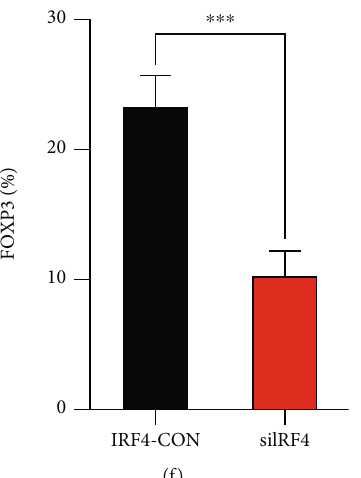
Figure 6: (a and b) PD-L1 ’ s fl ow cytometry analysis in siIRF4 DS cells in relation to restriction with or without IFN- γ therapy. (c and d) Flow cytometry was used to analyze Granzyme B + CD8 + T cell or IFN- γ + CD8 + T cell frequencies. (e and f) CD4 + T cell frequency or Treg (FOXP3) in the